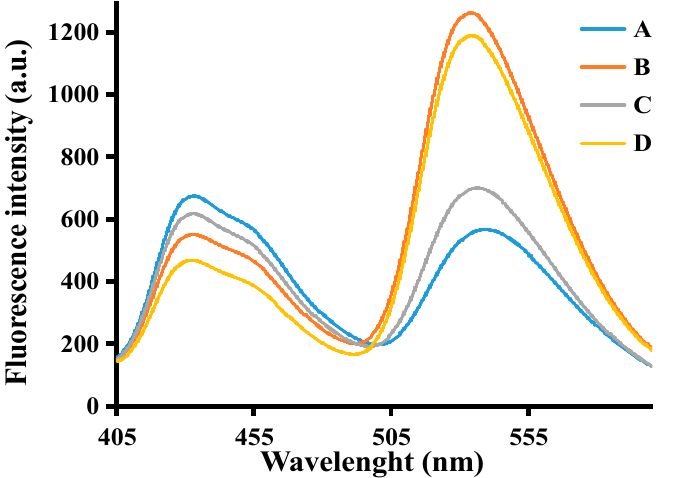
Figure 1. The feasibility of the proposed method. (A) P1 + SG I+ PFP; (B) P1 + P2 + SG I+ PFP; (C) P1 + Exo I+ P2 + SG I + PFP; and (D) P1 + SA + Exo I + P2 + SG I + PFP. Concentrations of P1, SA, Exo I, P2, SG I and PFP were 150 nM, 150 nM, 25 U/mL, 150 nM, 1 X and 0.8 μM , respectively.